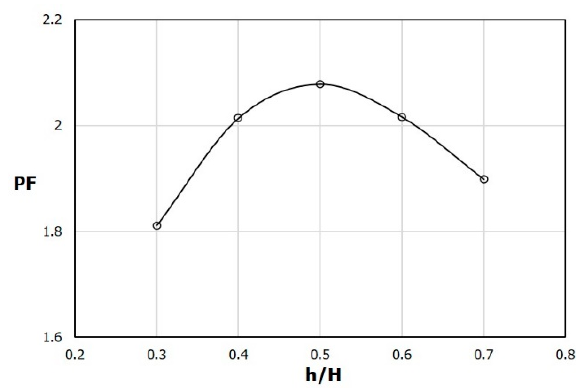
Figure 7. Variation of performance factor (PF) with h/H (e/W = 0.1).